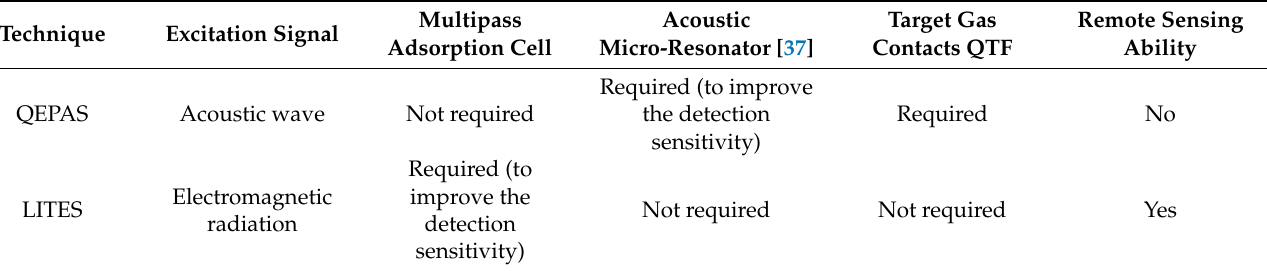
Table 3. Comparison between QEPAS and